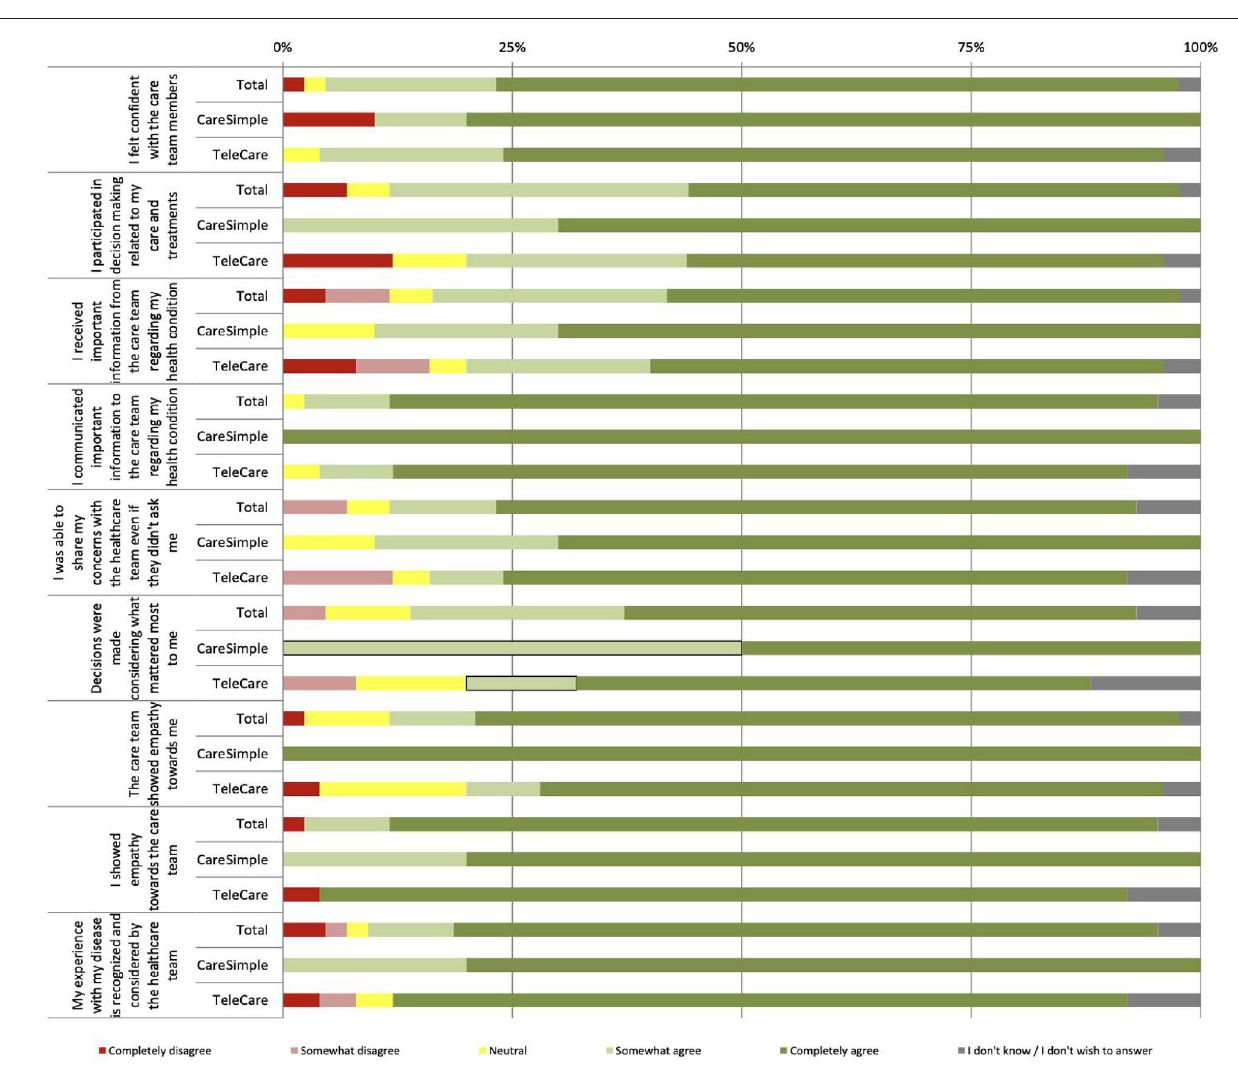
FIGURE 2 | Perception of engagement in care and the relationship with the care